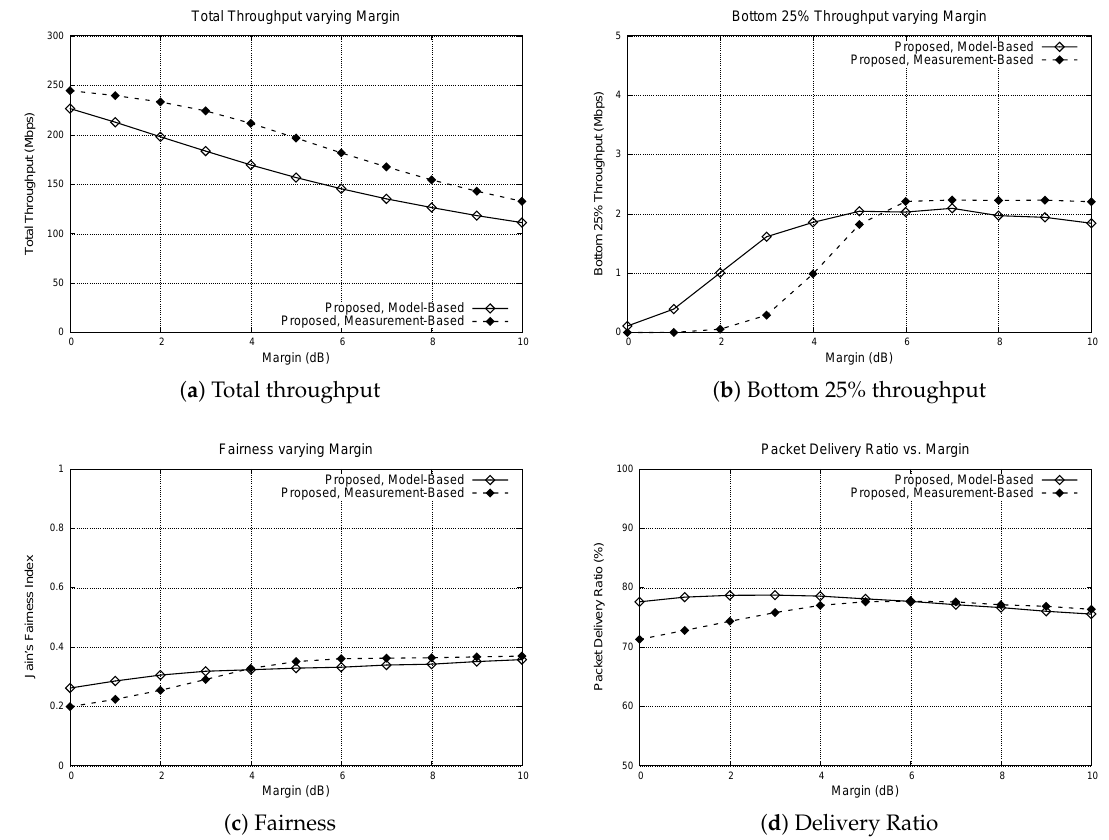
Figure 7. Performance of the model-based scheme and the measurement-based scheme varying margin. Number of APs and number of nodes are fixed to 100, and the margin is varied from 0 dB to 10 dB. ( a ) total throughput, ( b ) bottom 25% throughput, ( c ) Jain’s fairness index, ( d ) packet delivery